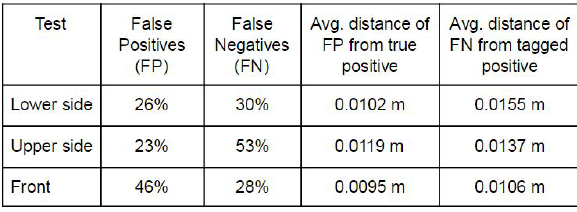
Figure 5. Ground truth tagging of the